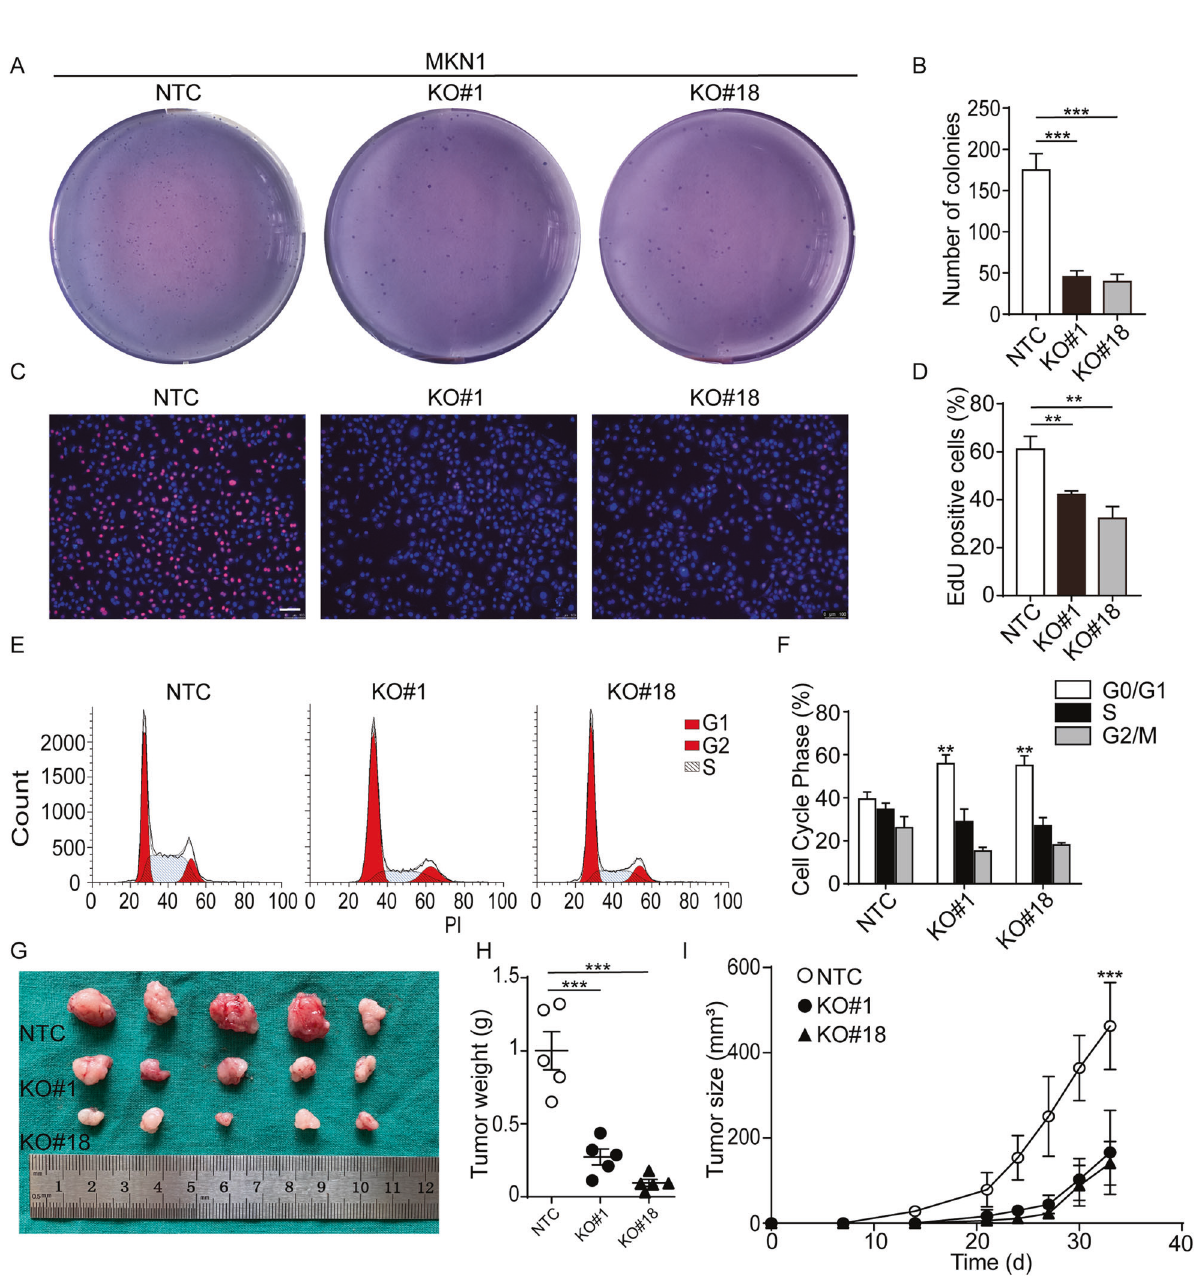
Fig. 2 Lack of ILK in MKN1 displayed signi fi cant G1/S cell cycle arrest. The proliferation of three MKN1 clones as indicated was measured by soft agar assays A and EdU assays C . Scale bar, 100 μ m. The number of colonies ( B ) and EdU-positive cells ( D ) were counted in fi ve fi elds. E Flow cytometry analysis of cell cycle distribution in these selected populations. And the percentage of three cell cycle phases was measured and compared among three groups ( F ). G Representative images of xenogra fi c tumors inoculated subcutaneously of three clonal cells in NSG mice were shown. H Tumor weights were measured at the experimental end point (tumor volume exceeds 1000 mm3). I Tumor sizes of cell-derived xenogra fi c bearing NTC, #1 and #18 cells were measured every 3 days. Data represent the mean ± SD of at least three independent experiments. ** p < 0.01 and *** p <